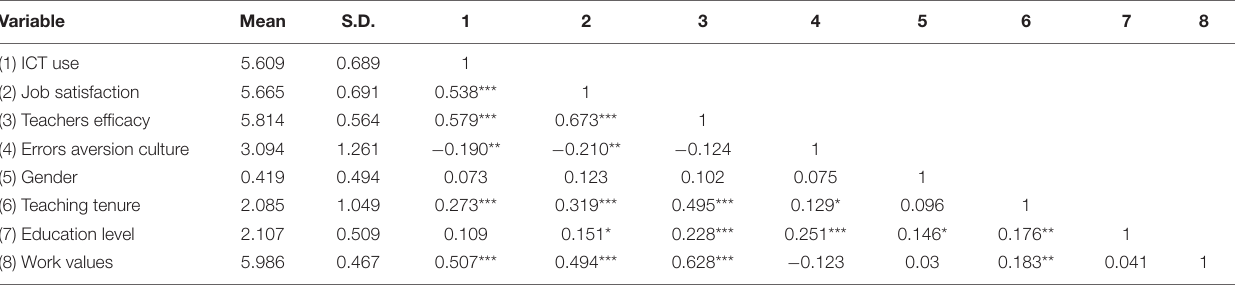
TABLE 3 | Mean, standard deviation, and correlation coefficient of all variables.